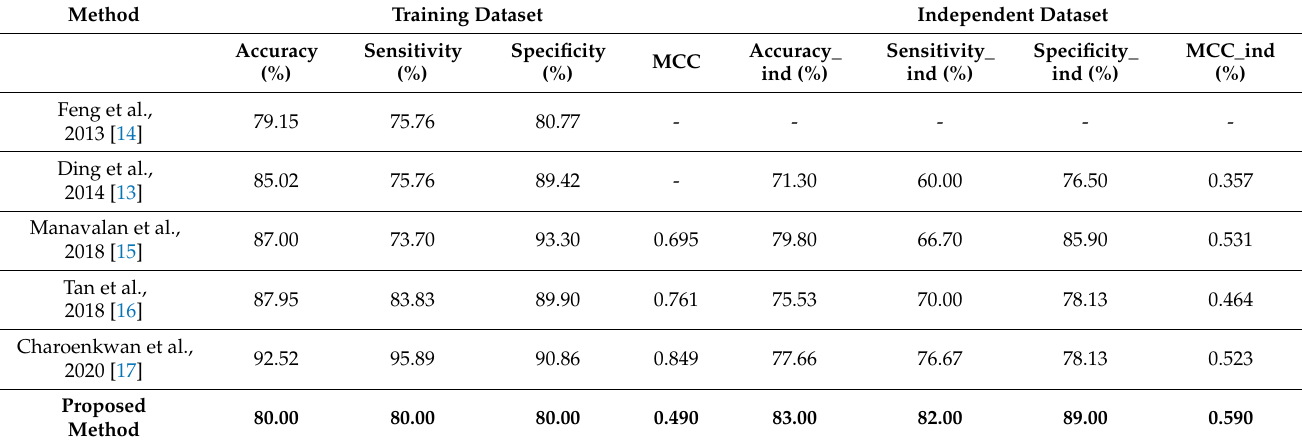
Table 3. Performance comparisons between the proposed method and other existing